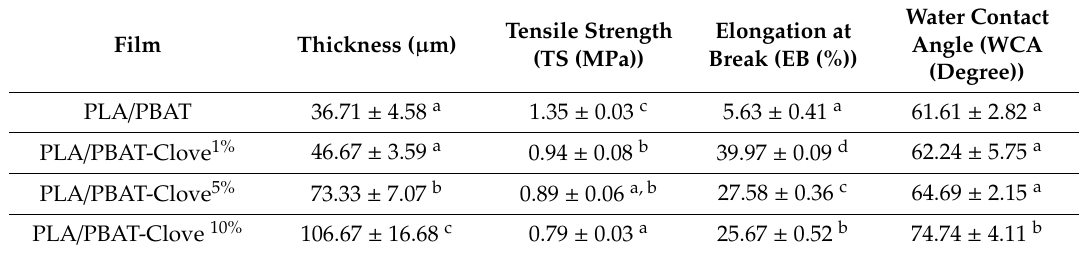
Table 4. Thickness, tensile properties and hydrophobicity of the clove oil composite